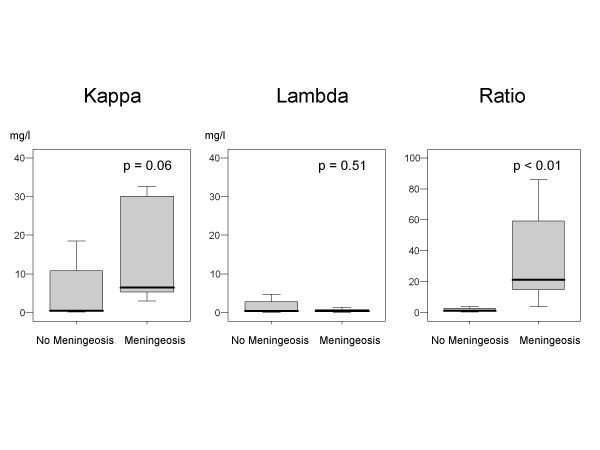
Comparison of kappa FLC, lambda FLC, and kappa/lambda FLC ratios in patients with and without lymphomatous meningitis.